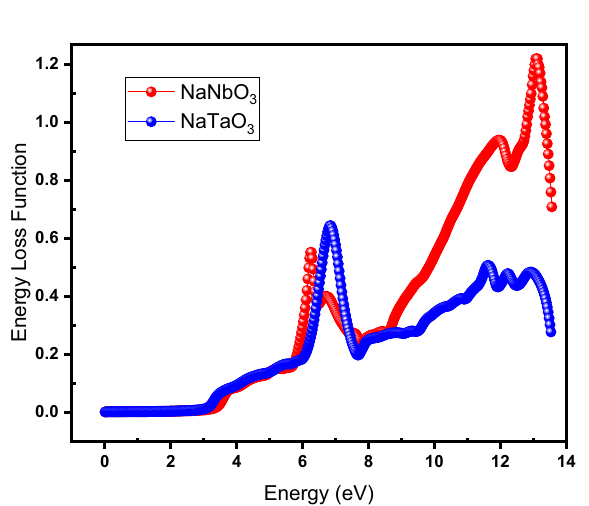
Figure 11. (Color Online) Energy loss function as a function of energy for NaNbO 3 (red) and NaTaO 3 (blue) oxide